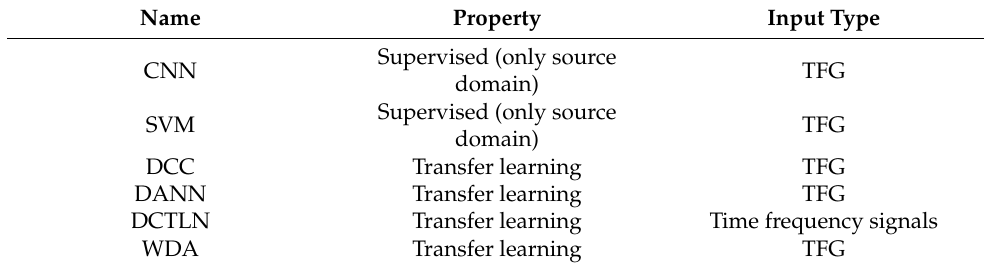
Table 5. Description of the training process of different methods.